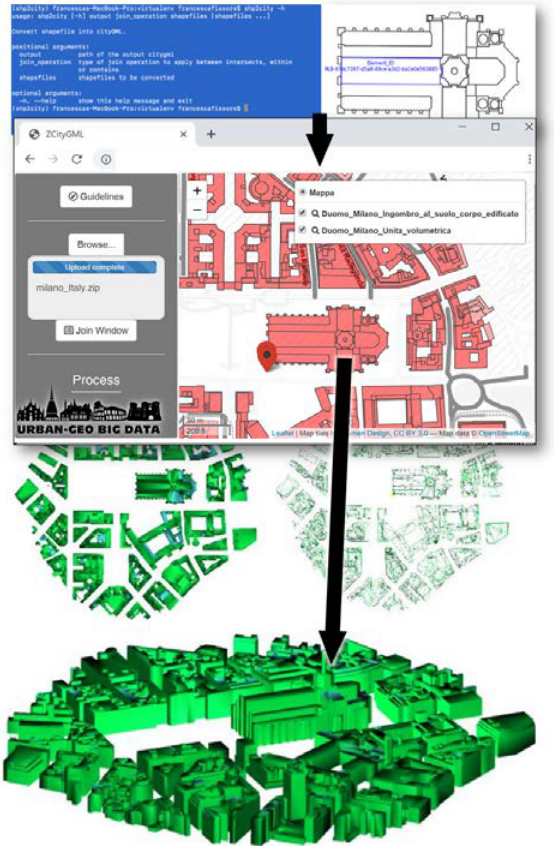
Figure 4. ETL procedure for converting ESRI Shapefiles to a CityGML Model; the area is the central square of the city of Milan (Fissore and Pirotti,